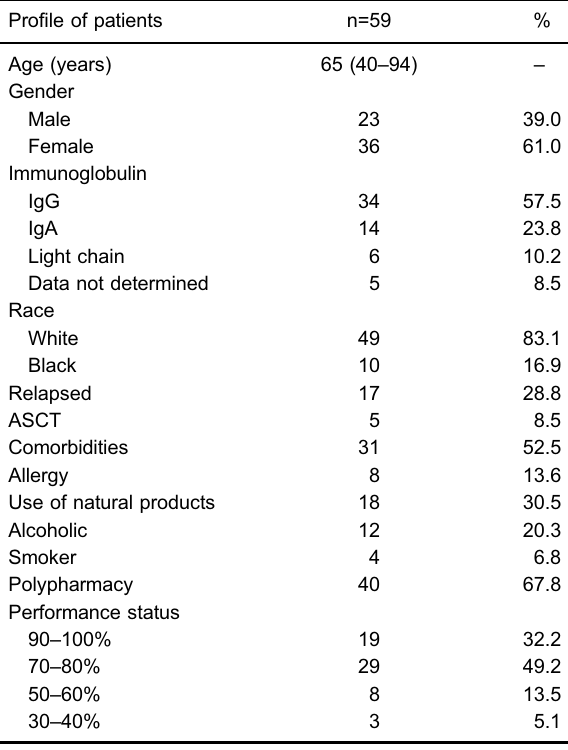
Table 2. Pro fi le of the multiple myeloma patients under treatment with bortezomib, thalidomide, or a combination of both